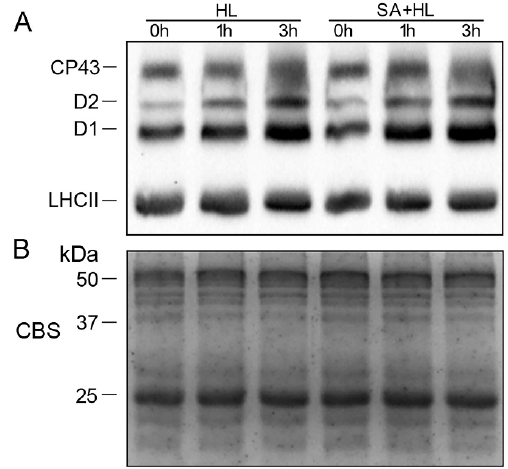
Figure 6. Thylakoid protein phosphorylation of Arabidopsis thaliana under high light in the presence or absence of SA. ( A ) Immunoblotting of thylakoid membrane proteins analysis was performed using antiphosphothreonine antibodies. ( B ) Coomassie blue staining (CBS) of SDS-PAGE was presented in the bottom panel. HL, high light. SA + HL, high light after SA pretreatment for 3 d. 0–3 h, high light for 0 h, 1 h, and 3 h in the presence or absence of SA pretreatment, respectively. Photoinhibition leads to photosynthetic imbalance through the photosynthetic electron transport chain, which, in turn, causes excess reactive oxygen species (ROS) formation. Direct color staining with NBT (blue) and DAB (orange) were used to detect the oxidative stress of detached leaves in the process of photoinhibition (Figure S7). NBT and DAB staining indicated that the detached leaves under high light accumulated more O 2 ˉ and H 2 O 2 compared to the control, while SA